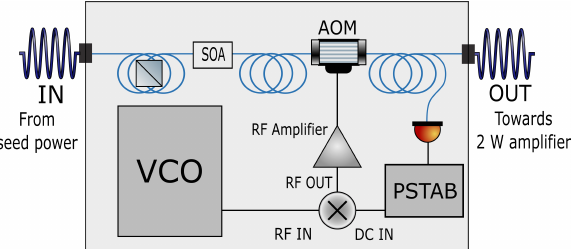
Figure 5. Sketch of the Electronic box. The polarization of the beam is cleaned thanks to a fibered polarizer, and is then amplified with a SOA and passes through a fibered AOM where only the 1st diffracted order is coupled into the fiber, so that at its output the beam is shifted in frequency by 80 MHz. The RF to drive the AOM is given by a VCO (Voltage-Controlled Oscillator) and the amount of diffracted light can be set thanks to a DC IN offset coming from a power stabilization loop